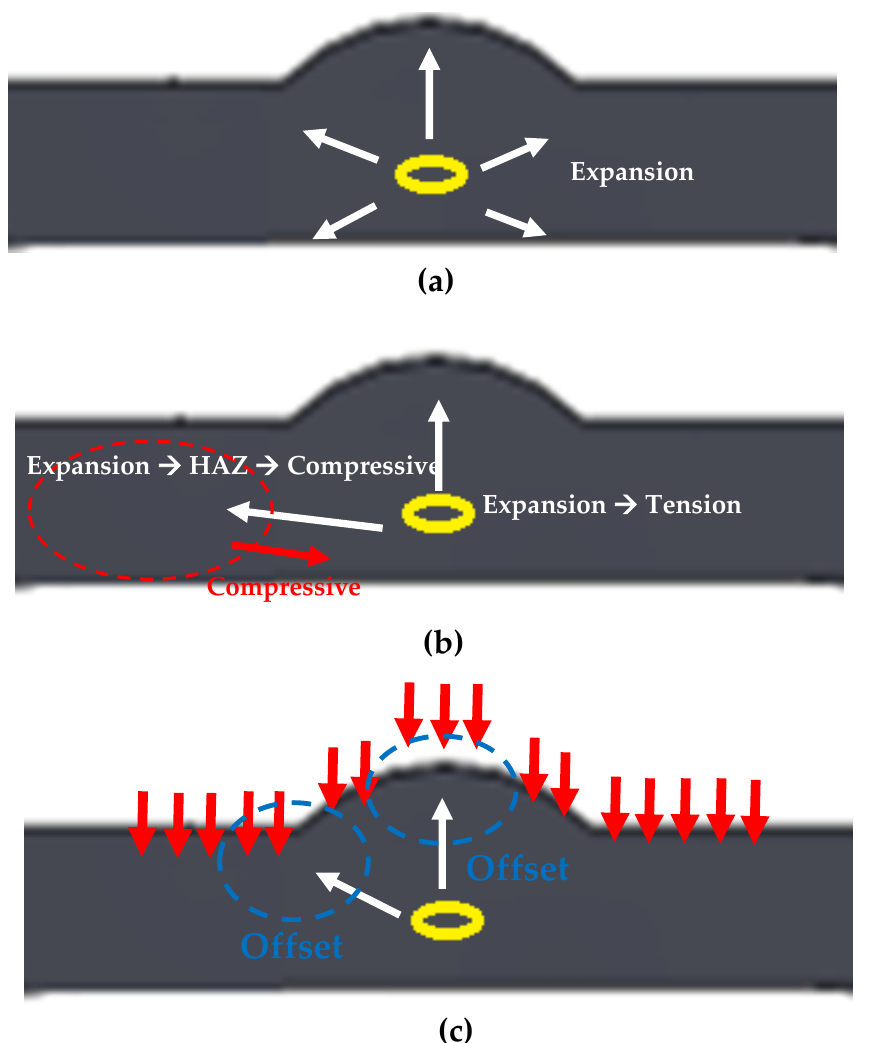
Figure 12. Schematic of residual stress generation at overlap defects. ( a ) Expansion force generated by the defect inside the bead; ( b ) Residual stress in the overlap-defect specimen; ( c ) Residual stress on the peened surface of the overlap-defect specimen.